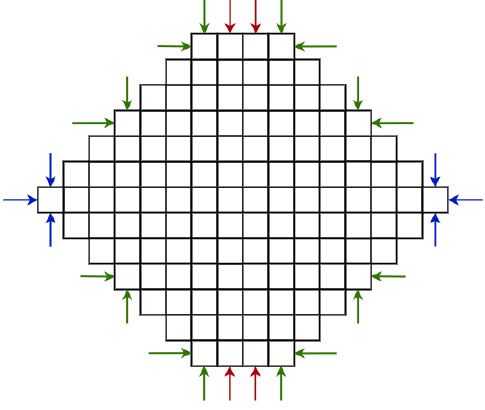
Figure 15. Border points’ acquisition.